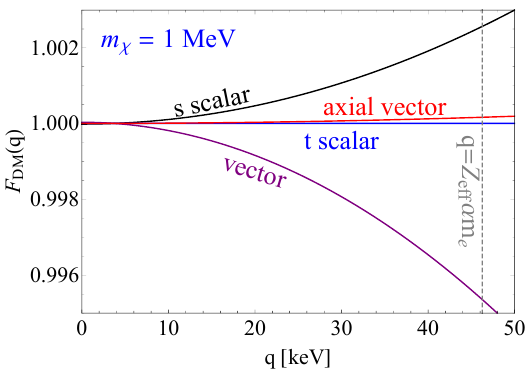
Figure 14 . The form factor F DM ( q ) as a function of q for four EFT operators: vector (purple), axial-vector (red), s-channel scalar (black), and t-channel scalar (blue). The typical q range in DMDD with Xe target is q . Z